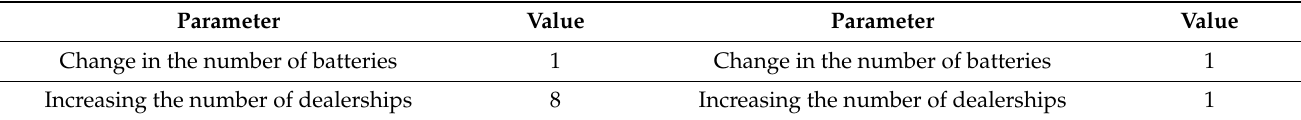
Table 15. Input parameters of the small battery storage strategy after 5 (left) and 10 (right) years.